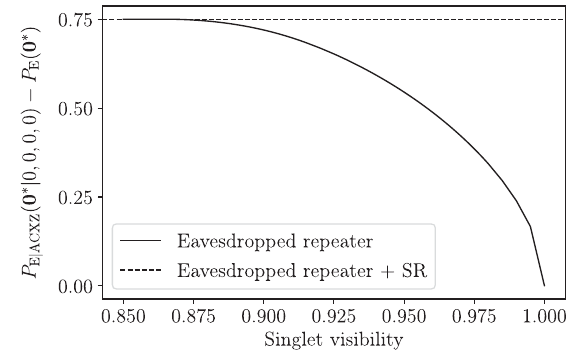
FIG. 15. Upper bounds to the total variation distance B , and C observe the distribution depicted in Eq. (D1) with singlet visibility v . The solid curve tracks the upper bound in the eavesdropped repeater network depicted in Fig. 14(a), whereas the dashed line tracks the worst case bound, when all the parties are coordinated through classical shared randomness, as in Fig. 14(b). The computations for the eavesdropped repeater network are carried out by considering its second-order quantum inflation and the moment matrix generated by operator sequences associated to the corresponding local level L 1 not exceeding length two.Thiscomputation results in a moment matrix of size 857 × 857 . ≤ min f 1 ; 2 ð 2 − R Þg offered On the other hand, the bound Δ a;c;x;z E ; E j AC ≤ 1 for this example, by Ref. [53] merely implies the trivial Δ 0 ; 0 ; 0 ; 0 ffiffiffi ffiffiffi E ; E j AC p p 2 2 as 2 ð 2 − R Þ evaluates to 2 ð 2 − v Þ and 1 ≤ 2 ð 2 − v Þ for all v ∈ ½ 0 ; 1 (cid:2)